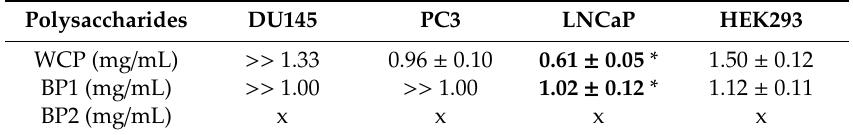
Table 3. 50% growth inhibition (IC 50 ) of prostate cancer (PCa) cells and HEK293 cell treated with WCP isolated from H. novae-zealandiae.